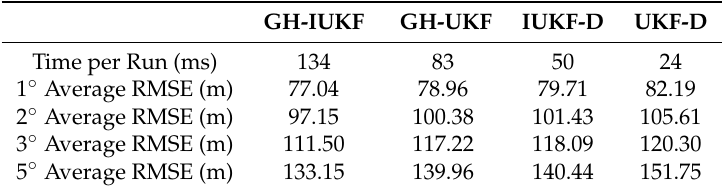
Table 1. Performance